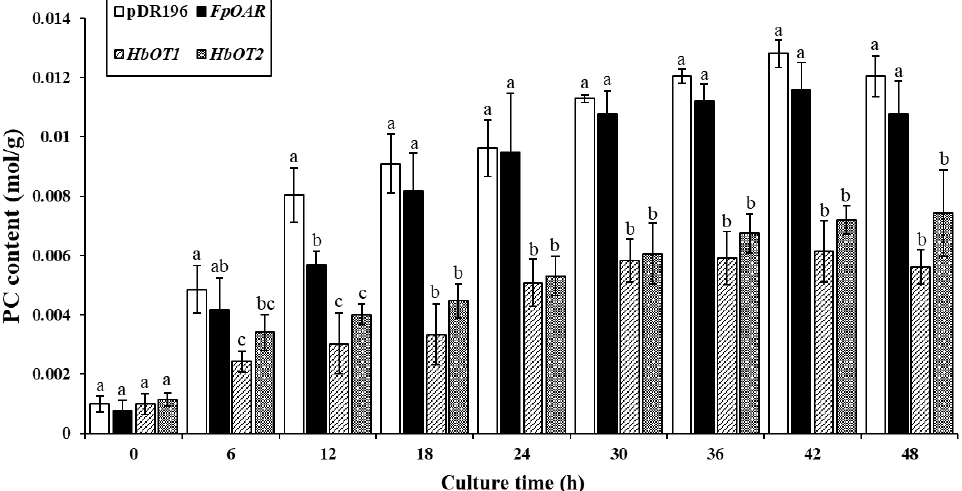
Figure 10. Changes of protein carbonyl content in yeast transformants under 2.7 mmol/L Al 3+ stress. Different letters indicate significant differences among different treatments at p < 0.05.